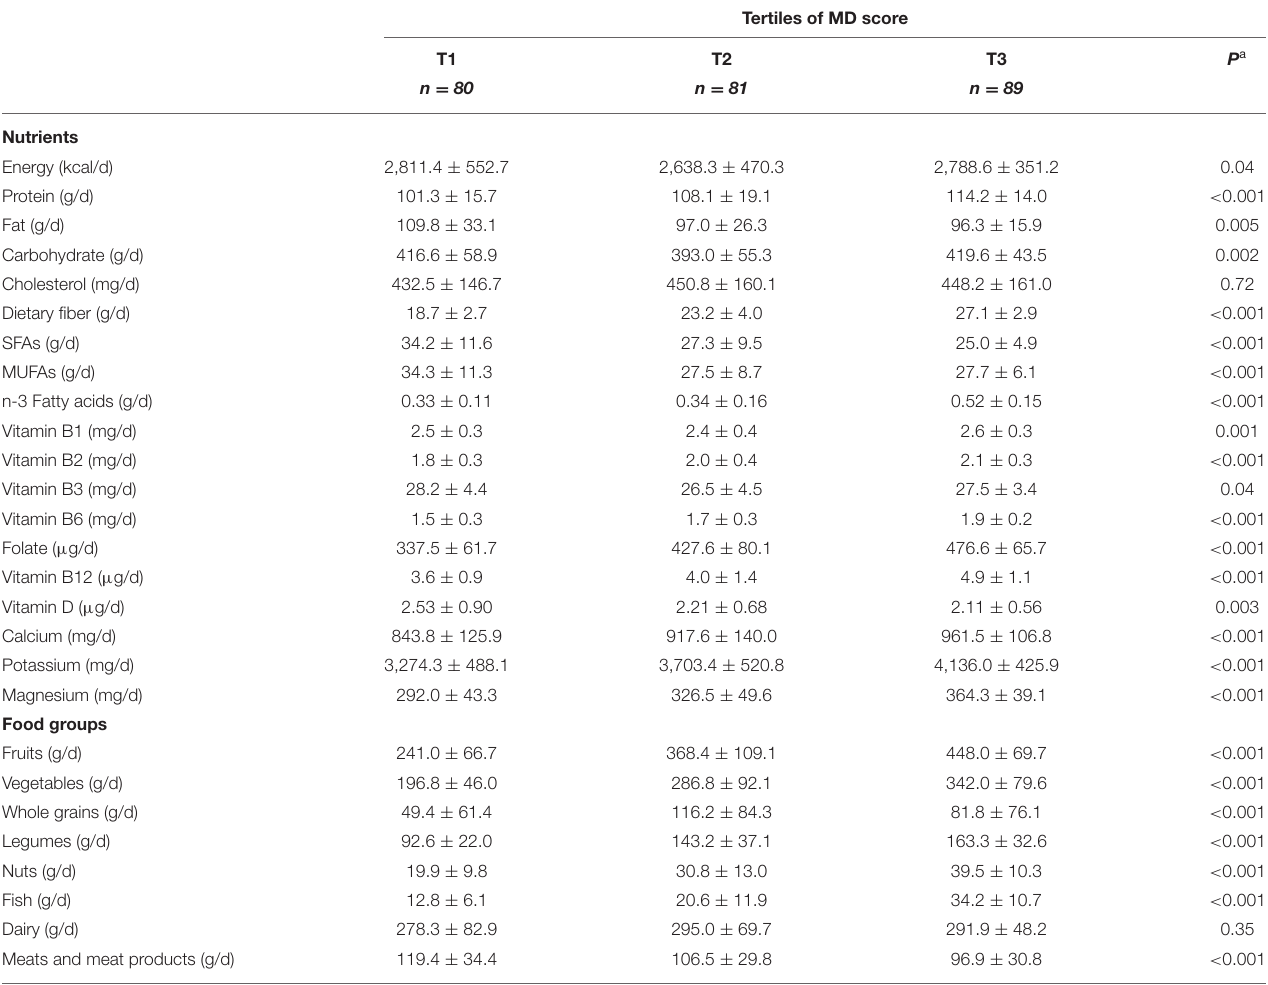
TABLE 2 | Selected food groups and nutrients intakes of participants across tertiles of Mediterranean diet score.